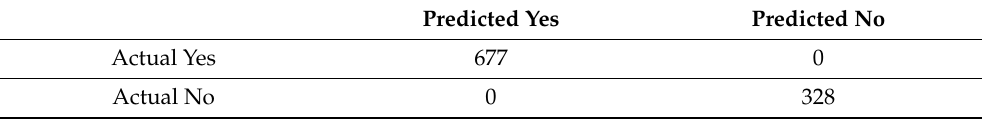
Table 10. Decision tree confusion